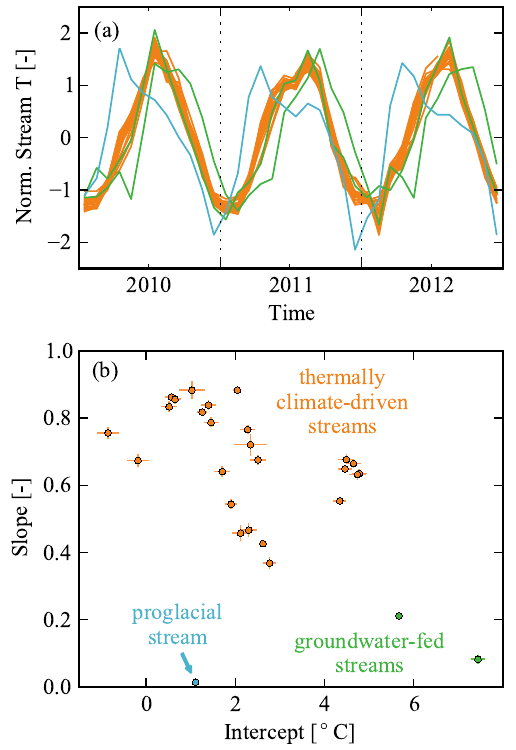
Figure 2. Classification of the thermal regimes of the selected catchments. Streams impacted by groundwater infiltration are shown in green, the proglacial stream in blue and the thermally climate-driven streams in orange. (a) Normalized monthly mean stream temperature curves over 3 consecutive years (2010–2012); all curves are z scored independently each year. (b) Slopes and intercepts of the regression lines fitted to the stream–air tempera- ture points of the respective catchments. All points with negative air temperature values have been discarded prior to fitting. The bars indicate the standard error